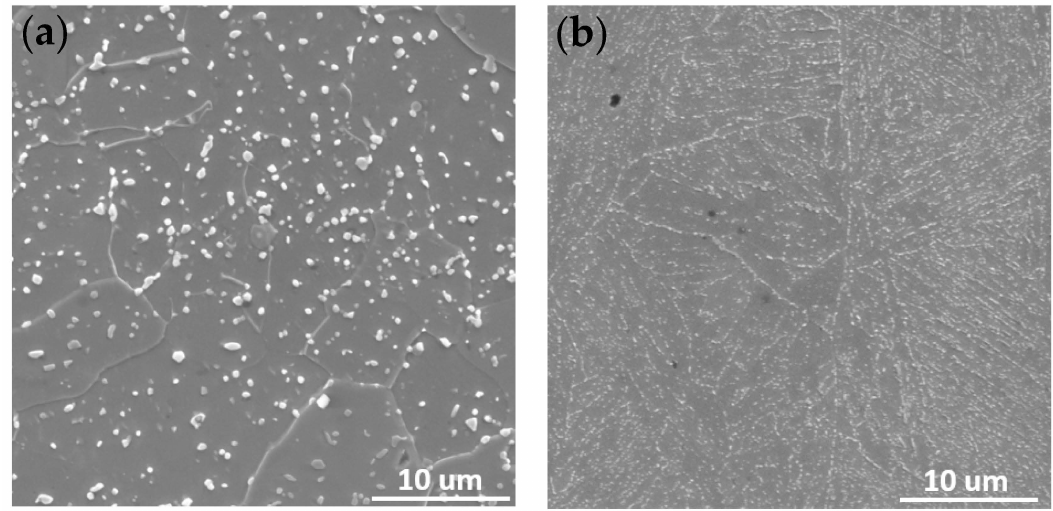
Figure 4. SEM image of X37CrMoV5-1 in ( a ) as-delivered state, ( b ) after DSC testing.